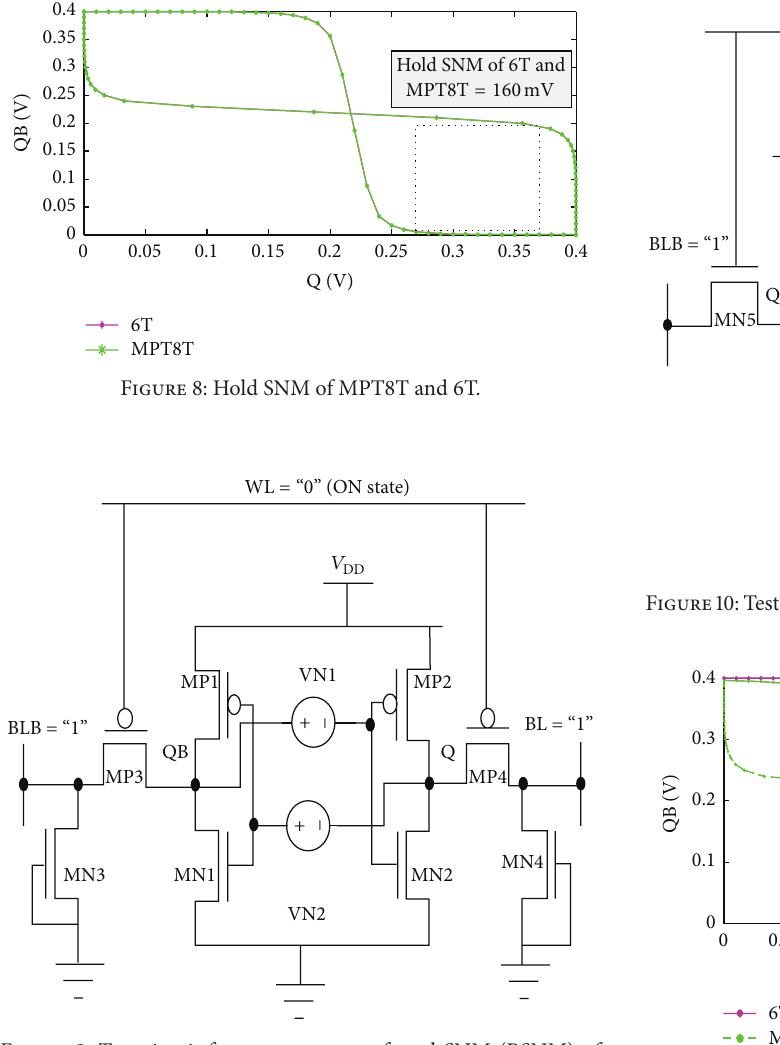
Figure 9: Test circuit for measurement of read SNM (RSNM) of MPT8T.